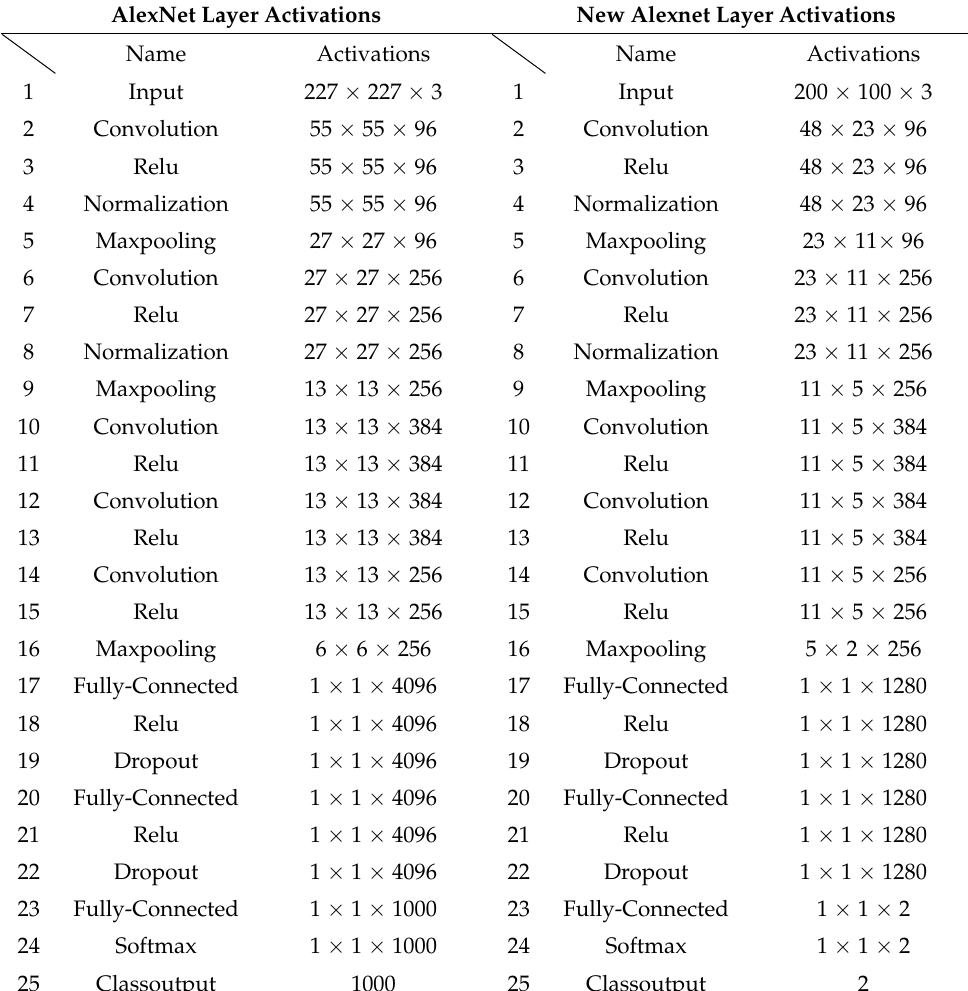
Table 2. AlexNet vs. new AlexNet layer